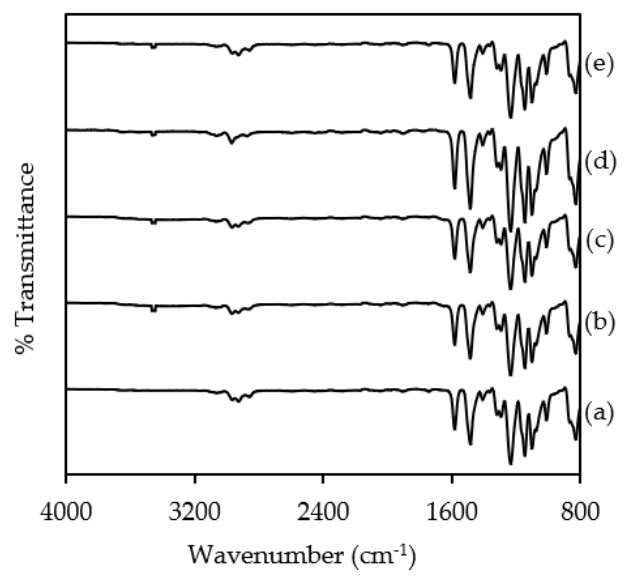
Figure 7. FTIR spectra of ( a ) PSF, ( b ) 1% NH 2 KIT-6/PSF, ( c ) 2% NH 2 KIT-6/PSF, ( d ) 3% NH 2 KIT-6/PSF, and ( e ) 4% NH 2 KIT-6/PSF.